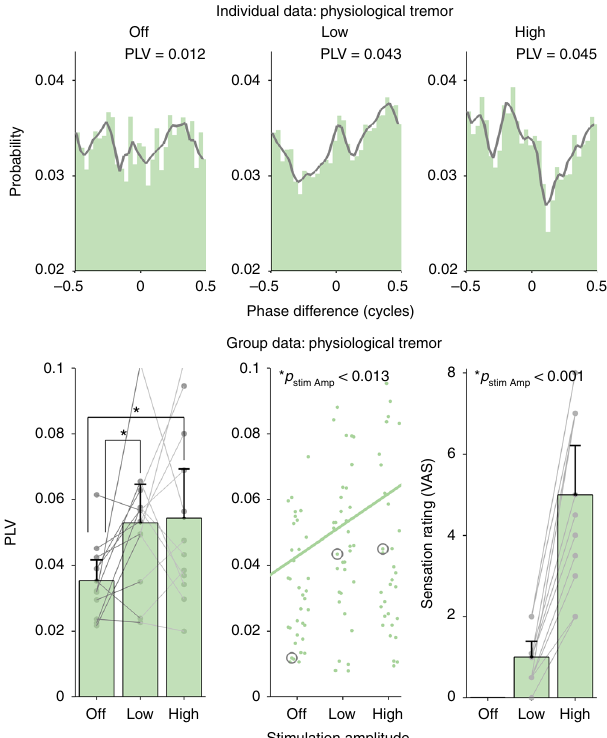
Fig. 6 Effect of transcutaneous-only stimulation on physiological tremor. In healthy volunteers, tACS electrodes were placed on the upper arm contralateral to the hand on which tremor was measured, effectively blocking any contribution from a potential transcranial mechanism. The top row shows phase-difference histograms for the three different amplitude conditions (OFF, LOW and HIGH) in one example subject (similar to Fig. 4). Even when the tACS electrodes were not positioned on the head, stimulation still caused physiological tremor entrainment in this subject. The bottom left panel shows the mean PLV for each subject ( n = 12) for each amplitude condition. Error bars on all panels show the con fi dence intervals. Individual data points (averaged over three repetitions) are shown as gray dots. The middle panel shows each individual data point (repetitions not averaged), with the gray circles indicating the examples shown in the top row. The trend line was calculated by fi tting a linear mixed model to the PLV data and using stimulation amplitude as a predictor. Even when tACS electrodes are not located on the head, increasing stimulation amplitude still caused a signi fi cant increase in tremor entrainment ( p = 0.013, linear mixed model). The right panel shows the mean sensation intensity rating for all subjects, using a visual analog scale (VAS) during each amplitude condition. Individual data points are shown as gray dots. The sensation intensity signi fi cantly increases with increasing stimulation amplitude ( p < 0.001, linear mixed model). This set of data indicate that